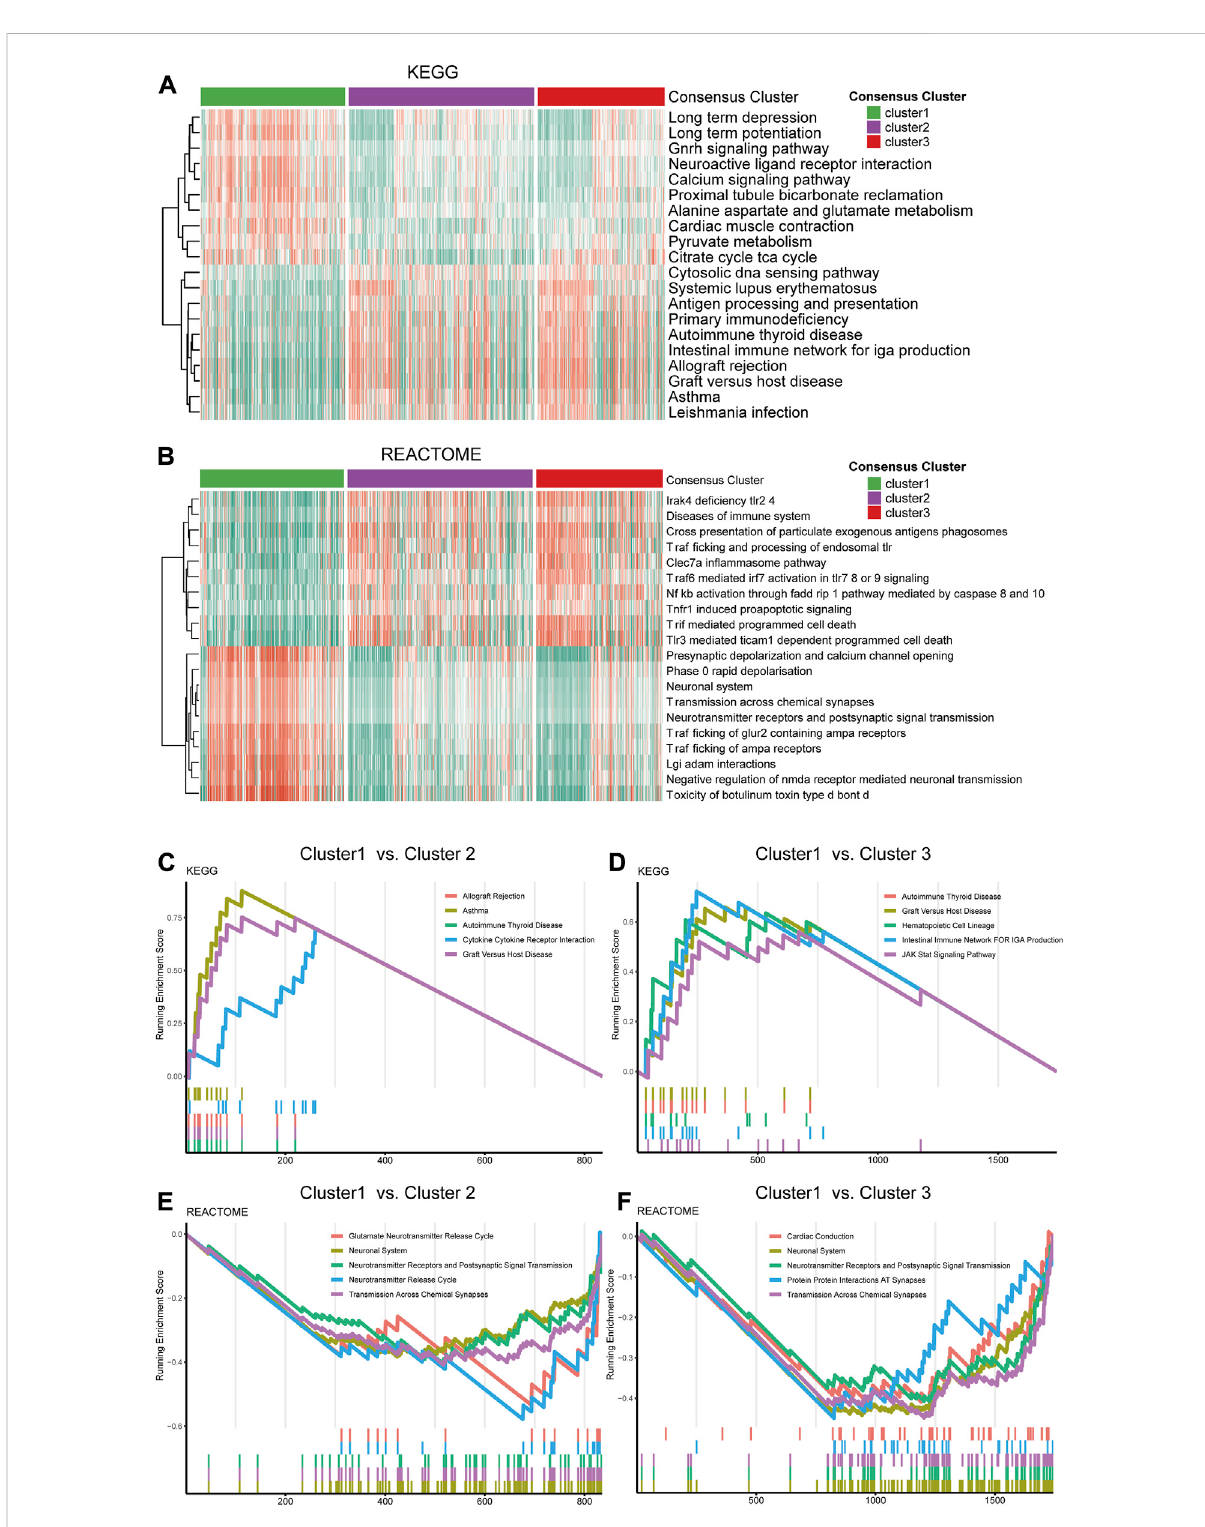
FIGURE 3 Functional analysis of the transcriptome of the consensus clusters. (A) Top 20 differentially expressed KEGG gene sets. (B) Top 20 differentially expressed REACTOME gene sets. (C) Top fi ve pathways with the highest normalized enrichment score in the KEGG gene sets between cluster1 and cluster2, (D) betweencluster1andcluster3. (E) Top fi vepathwayswiththehighestNESintheREACTOMEgenesetsbetweencluster1andcluster2, (F) between cluster1 and cluster